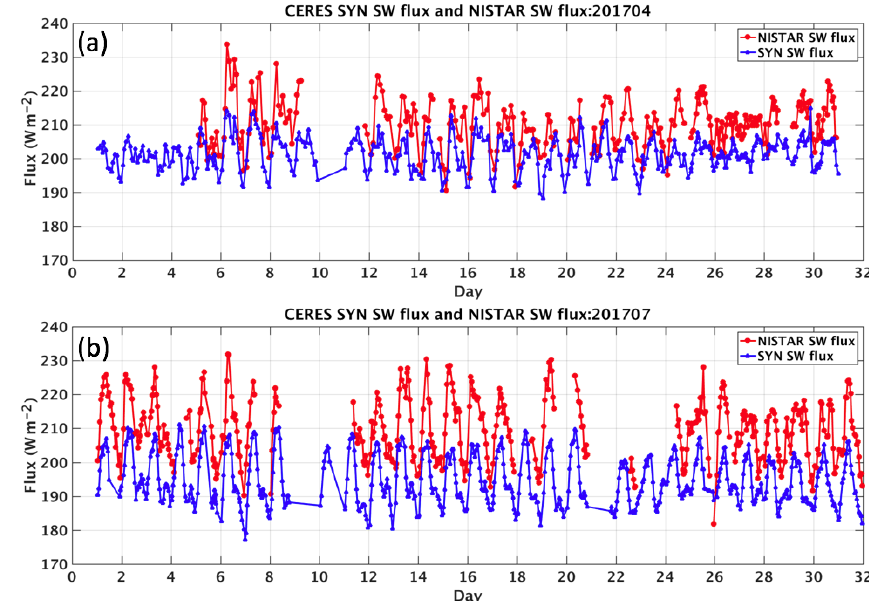
Figure 7. SW flux (Wm − 2 ) comparisons between NISTAR and CERES SYN for April (a) and July (b) 2017.